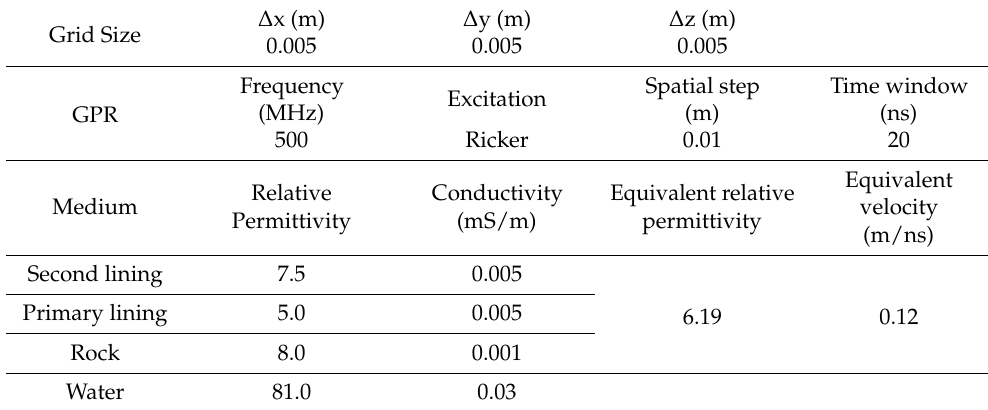
Table 1. Model parameters.